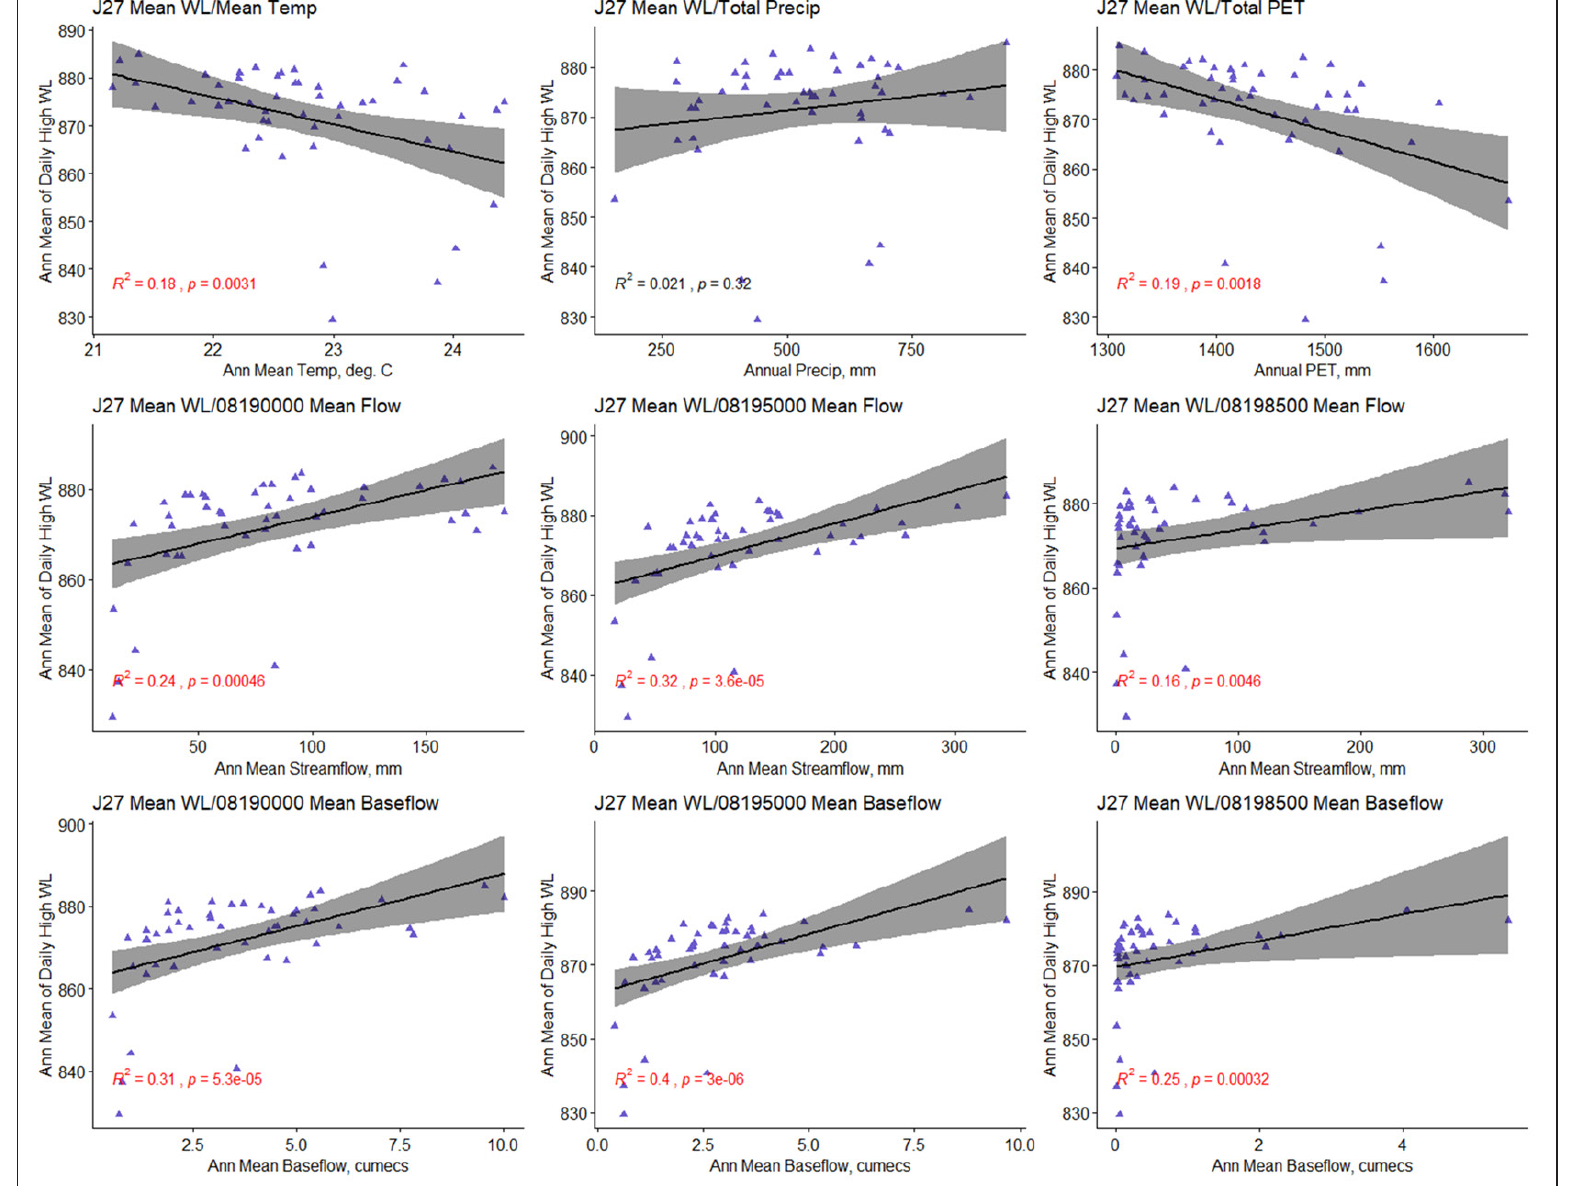
Figure 8. Regression analysis between the annual mean of daily-high water levels at well J27 and CRU variables in the EPE grid and annual mean flows and annual mean baseflows in upgradient gages (r 2 is shown in red where p≤0.05; the gray bands show the 90% confidence limits; cumecs = m 3